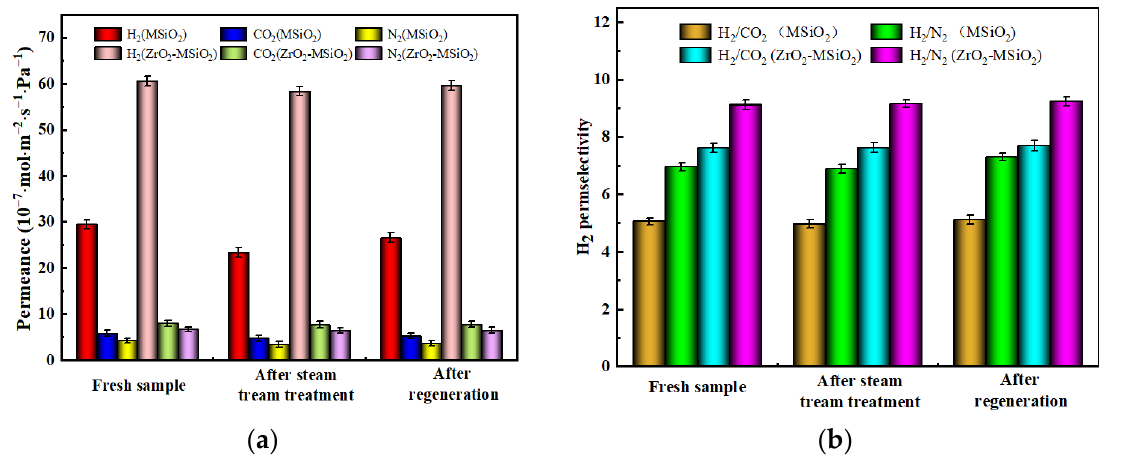
Figure 17. Effect of hydrothermal conditions on the ( a ) gas permeances and ( b ) H 2 permselectivities of MSiO 2 and ZrO 2 -MSiO 2 (n Zr = 0.15) membranes with 0% DCCA addition at a pressure difference of 0.1 MPa and 25 °C.